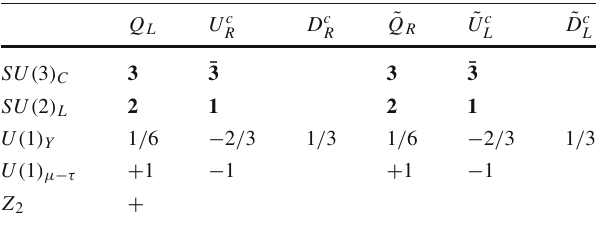
Table 2 The charge assignment of heavy vector-like quarks under SU ( 2 ) L × U ( 1 ) Y × U ( 1 ) μ − τ × Z